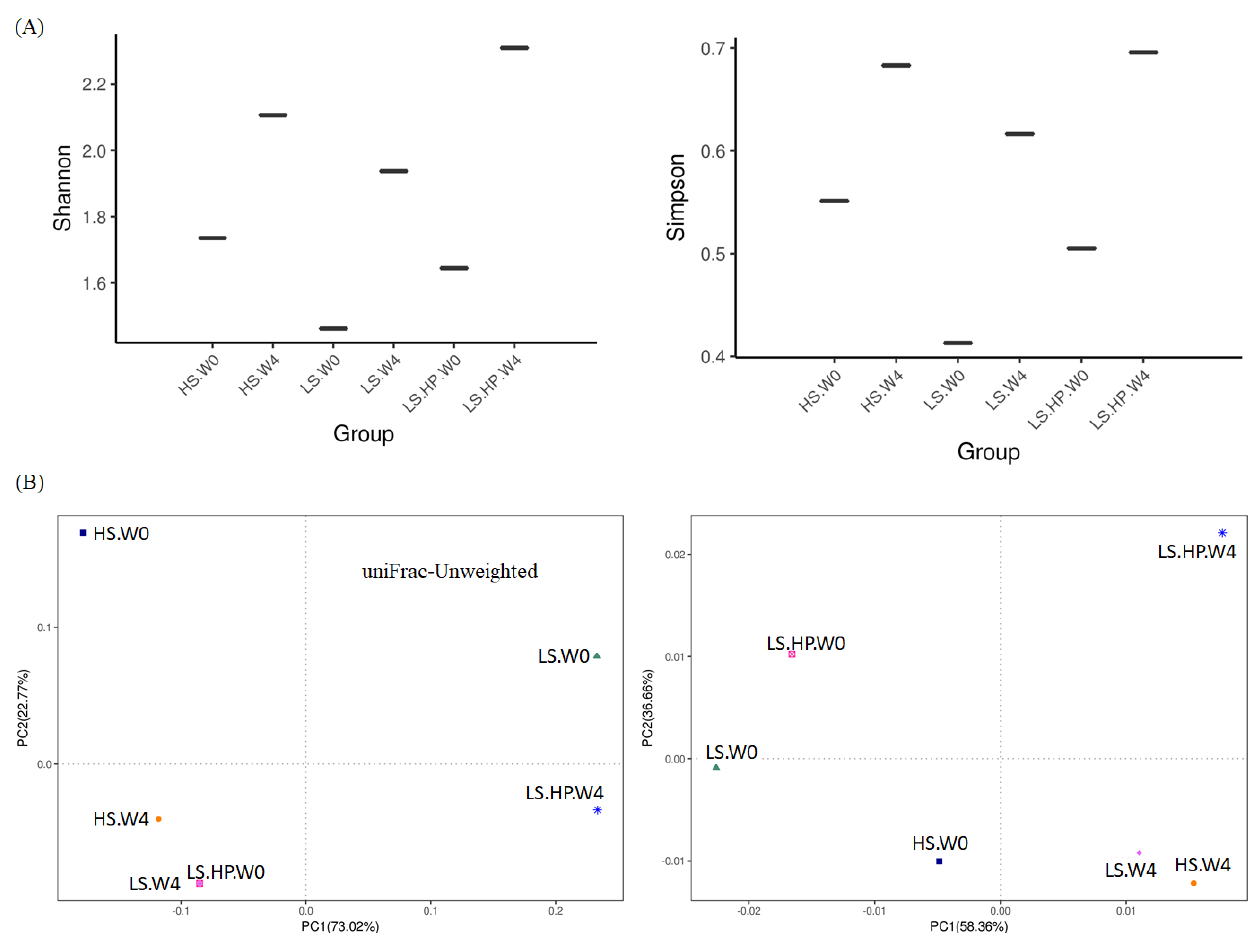
Figure 2. ( A ) The Shannon–Weiner and Simpson’s indexes of alpha-diversity, and ( B ) The unweighted and weighted uniFrac PCoA plots of beta-diversity obtained from analysis of bacteria microbiota in high-salt (HS), low-salt (LS), and low-salt high-pressure (LS-HP) soy sauce during fermentation.